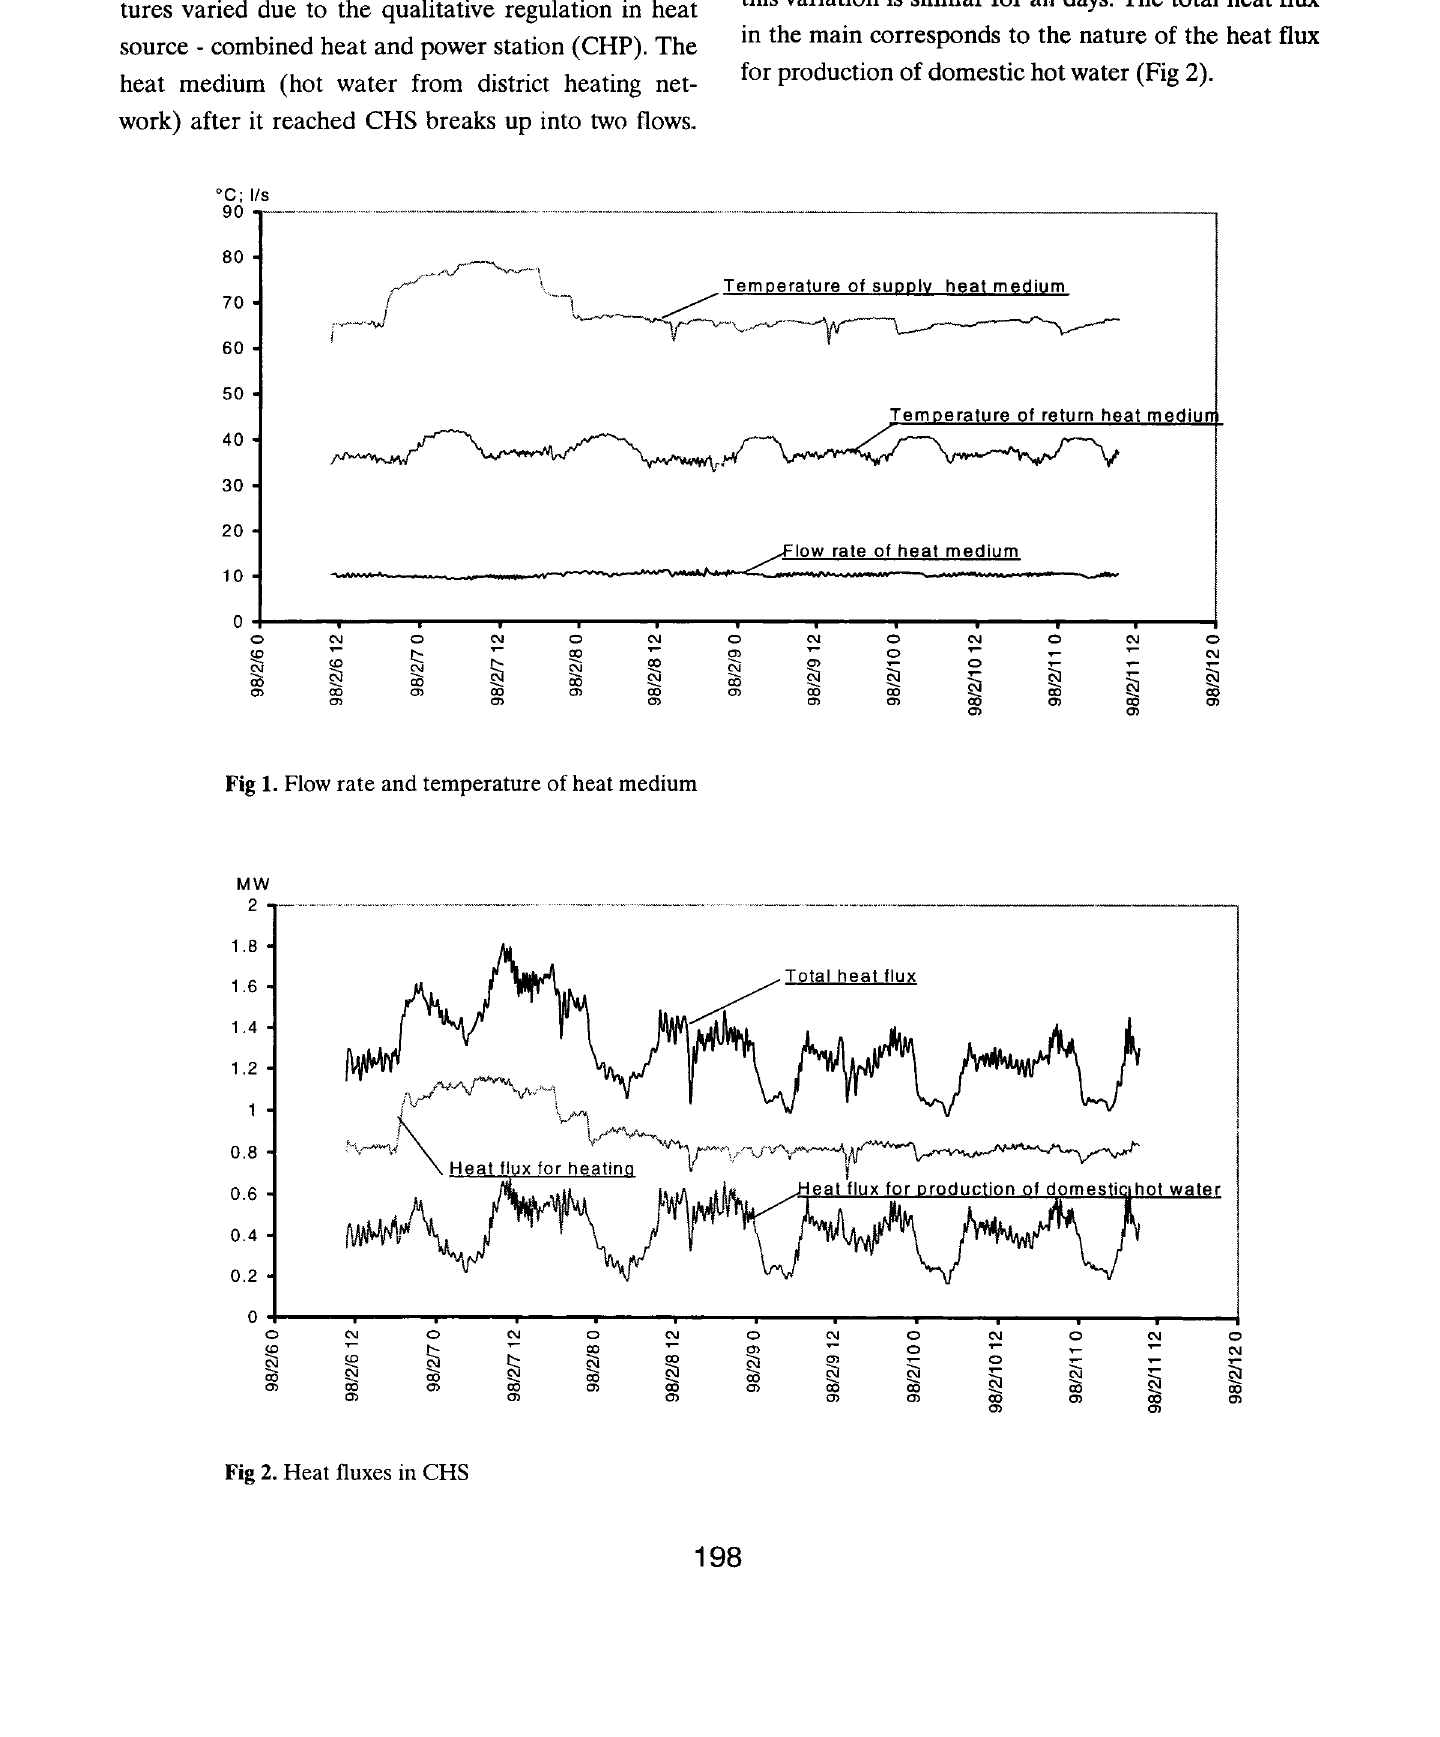
Fig 1. Flow rate and temperature of heat medium